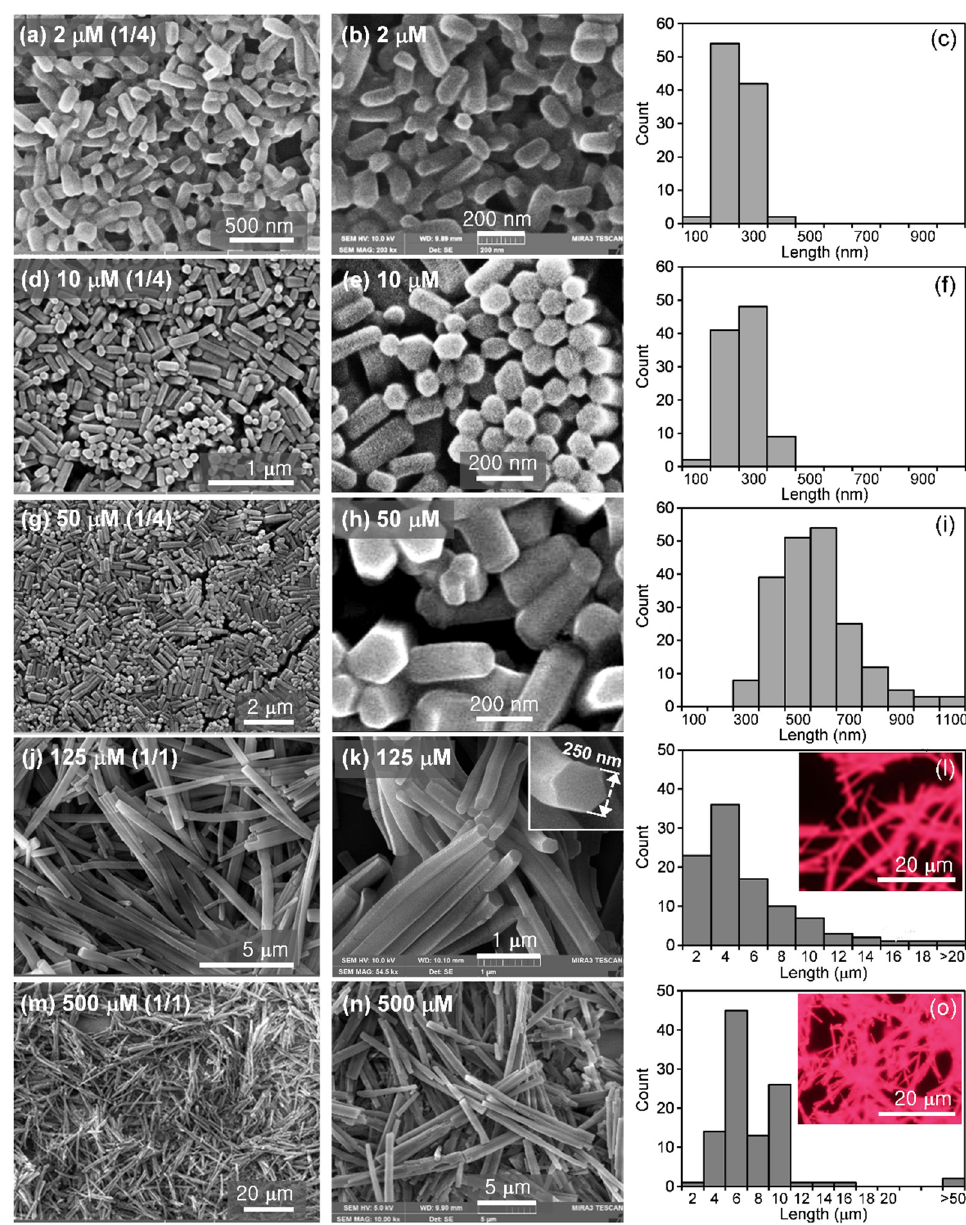
Figure 3. Characterization of hexagonal structures assembled from compound 1 . ( a – c ) 2 μ M THF- H 2 O (1/4, v / v ), ( d – f ) 10 μ M THF-H 2 O (1/4, v / v ), ( g – i ) 50 μ M THF-H 2 O (1/4, v / v ), ( j – l ) 125 μ M THF-